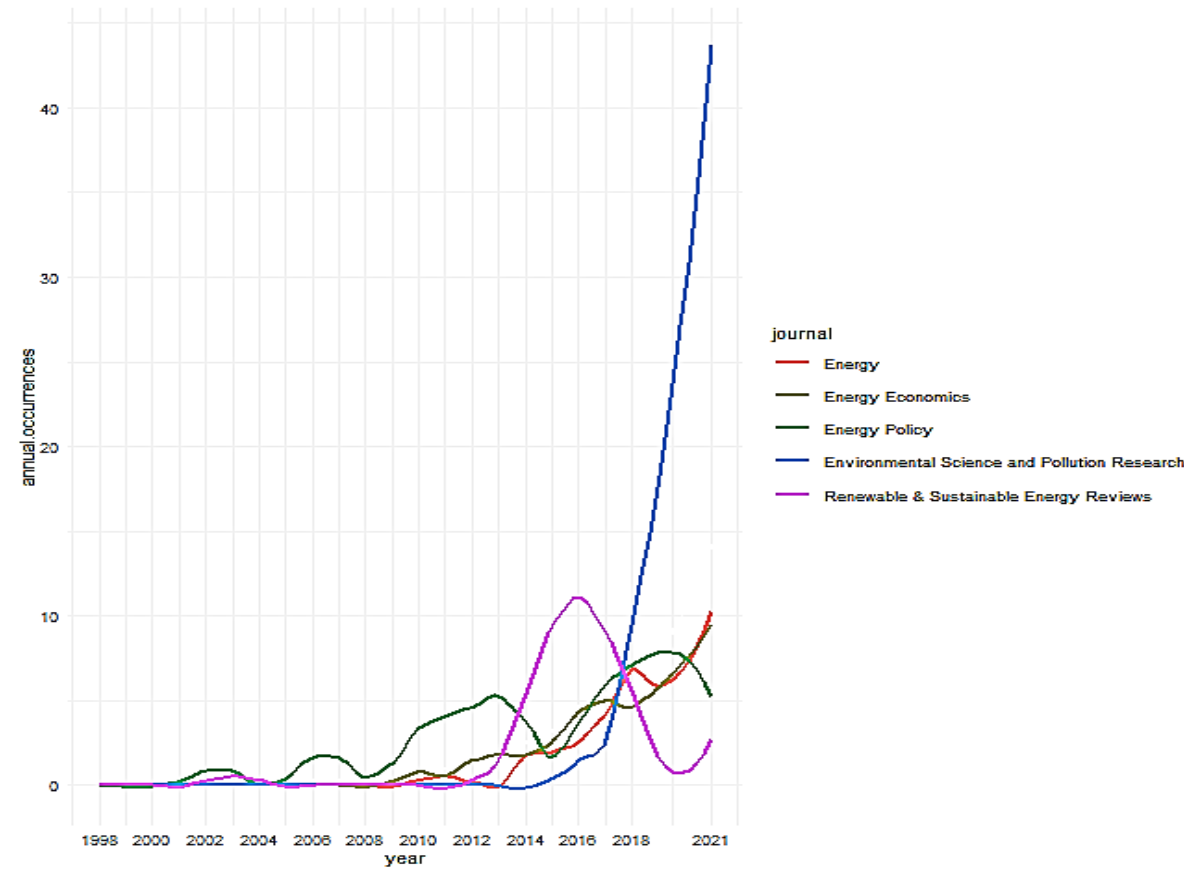
Figure 5. Annual increase in the occurrence of the top five journals.